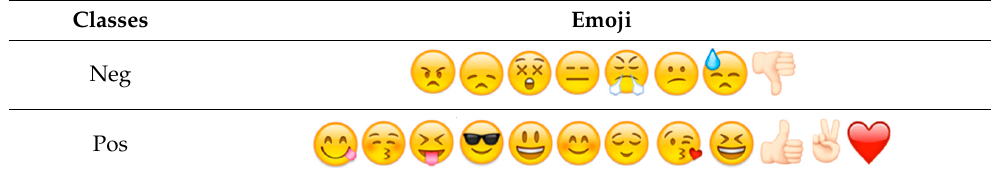
Figure 7. Data preprocessing flow chart. After the text was input, it was preprocessed to classify 1– 2 stars as poor ratings and 4–5 stars as good ratings. A rating of 3 stars was a medium rating, which was not used in this paper [29]. The pre-processing process loaded deactivated word lists and re- moved meaningless words, punctuation, special symbols, etc. Finally, the training set, test set, and validation set were divided according to the ratio of 8:1:1. Table 1. Emotional emojis for labeling.